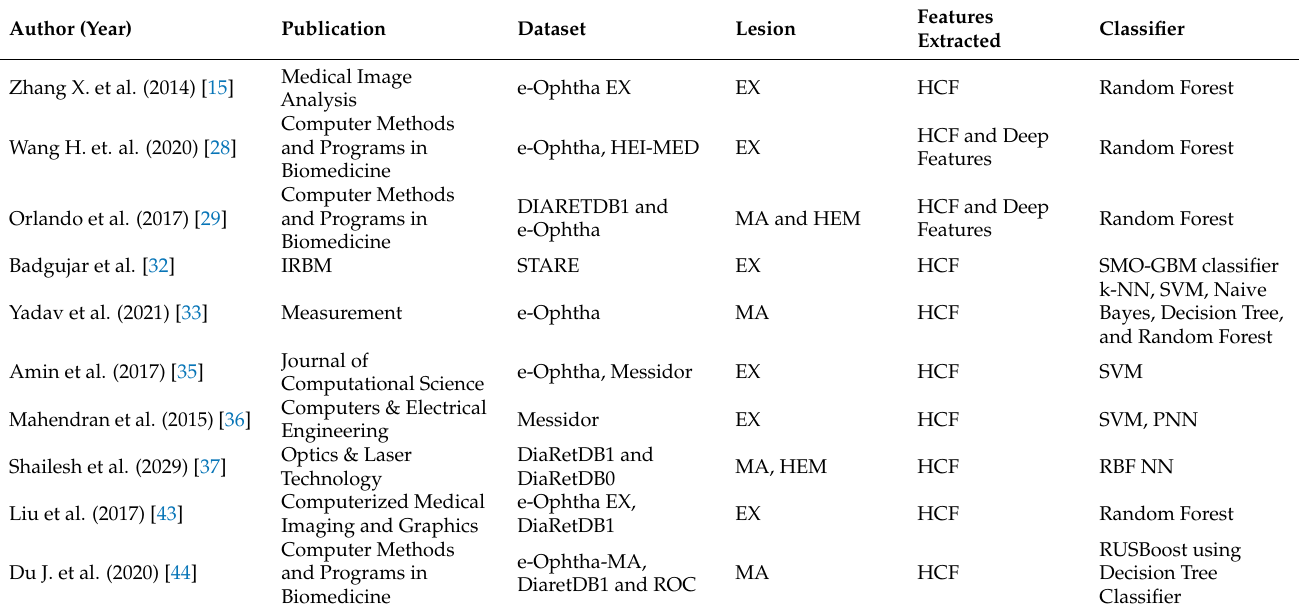
Table 6. Supervised machine learning styles used in the